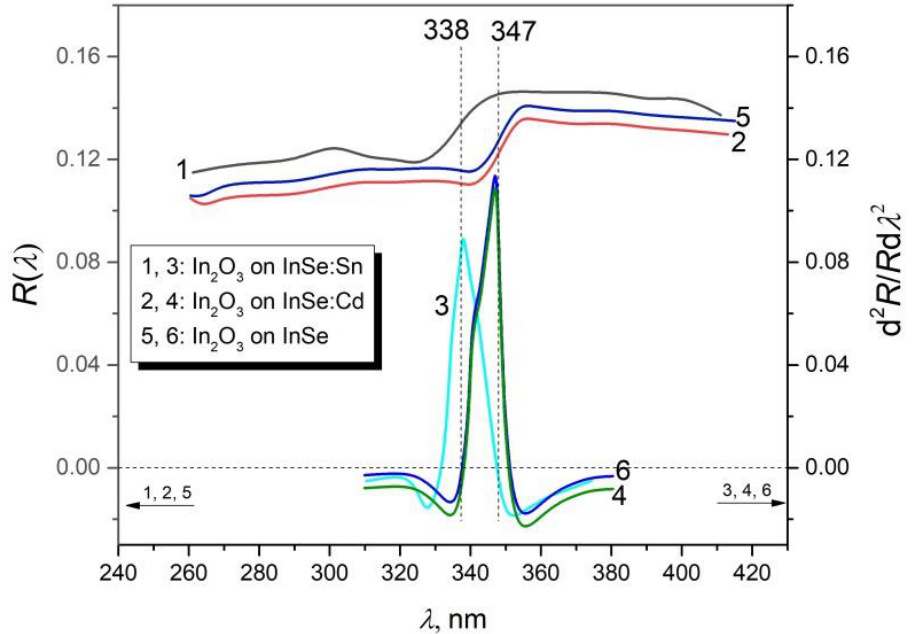
Figure 3. Reflection spectra of the In 2 O 3 layer on InSe:Sn (curve 1), InSe:Cd (curve 2), and undoped InSe (curve 5) substrates and their second derivatives with respect to wavelength (curves 3, 4, and 6, respectively).